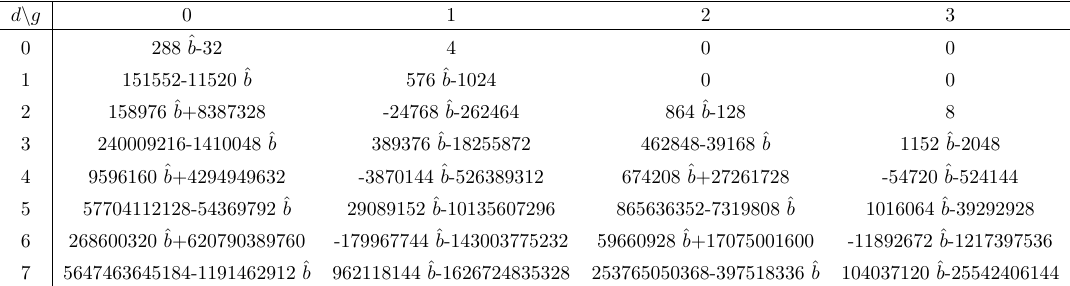
Table 3 . Gopakumar-Vafa invariants of the K 3 at base degree